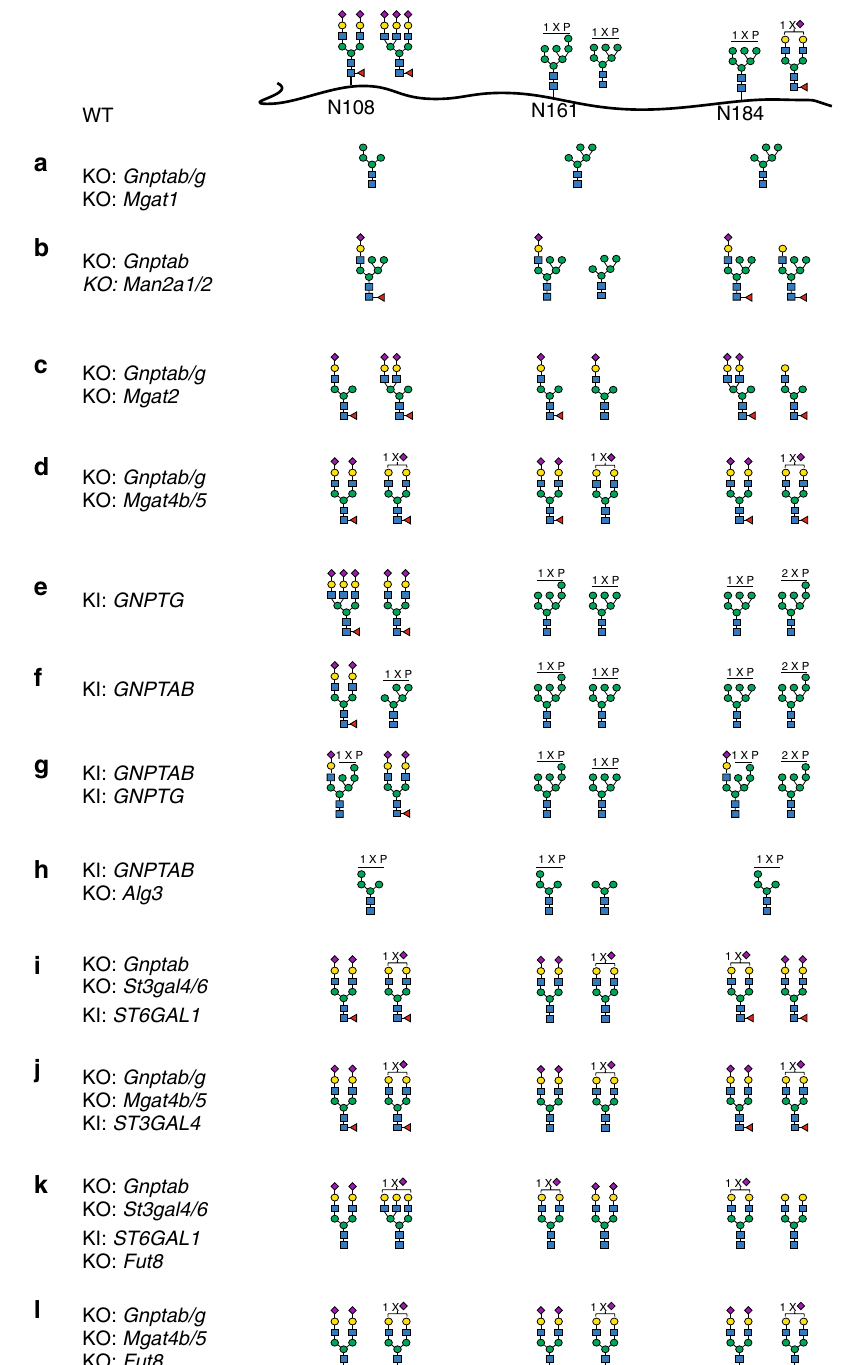
Fig. 3 Site-speci fi c glycan analyses of α -galactosidase A (GLA) glycoforms produced with combinatorial gene engineering of CHO cells. a – l The two most abundant glycan structures at N-glycosites (N108, N161, and N184) of GLA are shown. Each glycan structure was con fi rmed by targeted tandem mass spectrometry (MS/MS) analysis. The detailed N-glycan analyses of all GLA glycoforms are shown in Supplementary Fig. 2 together with additional variants. Details regarding the stacking ancestry and sequence analysis are shown in Supplementary Table 2 and Supplementary Data